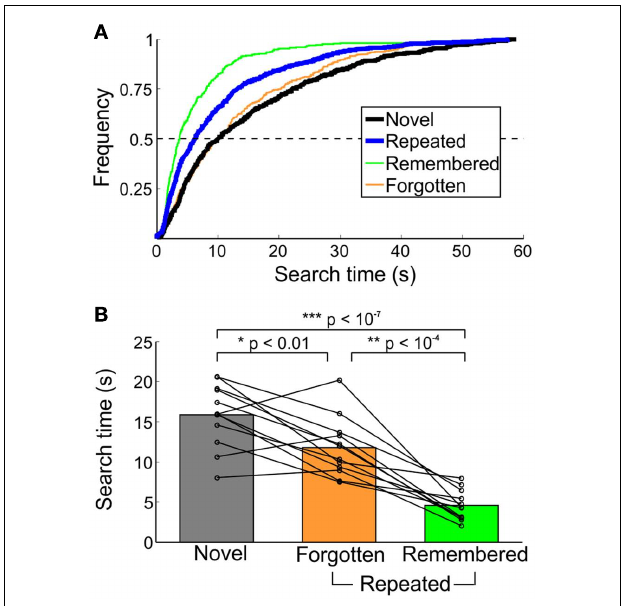
FIGURE 3 | Characterization of search times from healthy humans in Experiment 1. (A) Cumulative frequency of novel and repeated search times, collapsed across all participants.Trials not found in the 60-s time limit were excluded. (B) Median search times by memory category. Each line represents the median time to detect the changing object for an individual participant; bars indicate the group mean. All trials (both found and not found) are